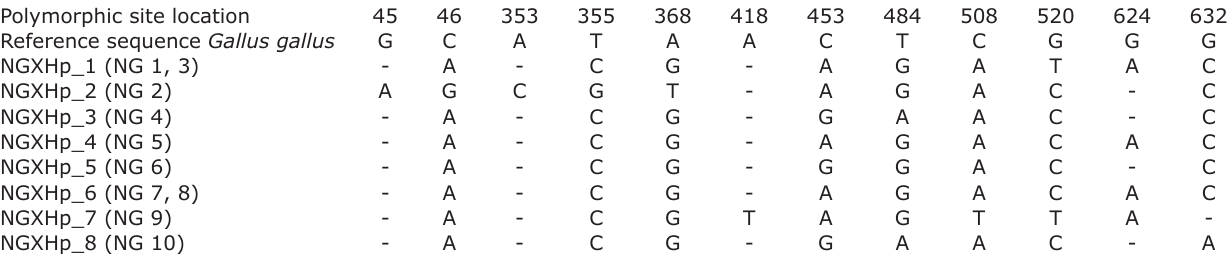
Table-2: Molecular definitions of eight COX I haplotype from Aravali chicken population.